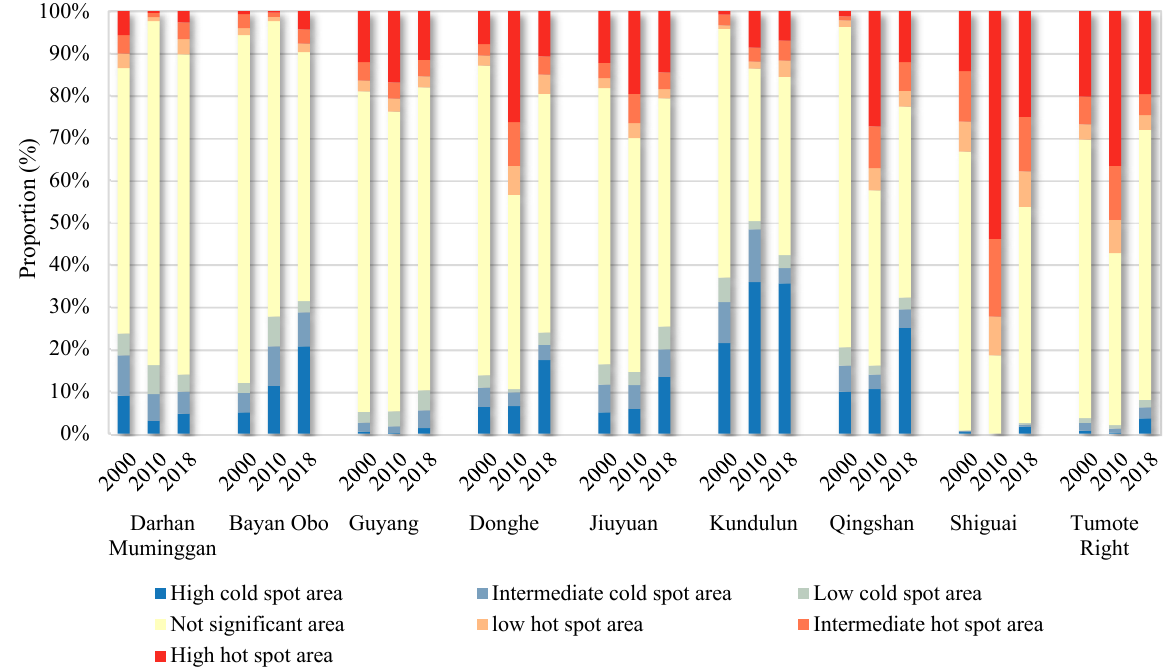
Figure 8. Area statistics of hotspot analysis of ESV.